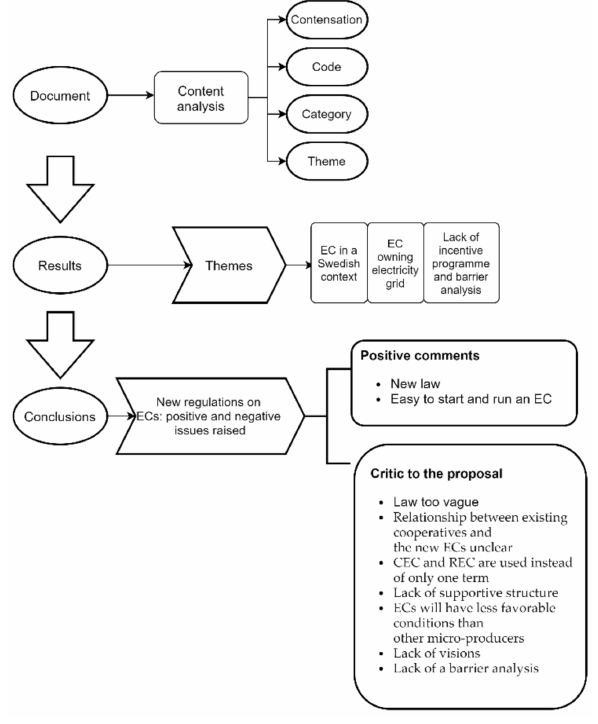
Figure 1. The research